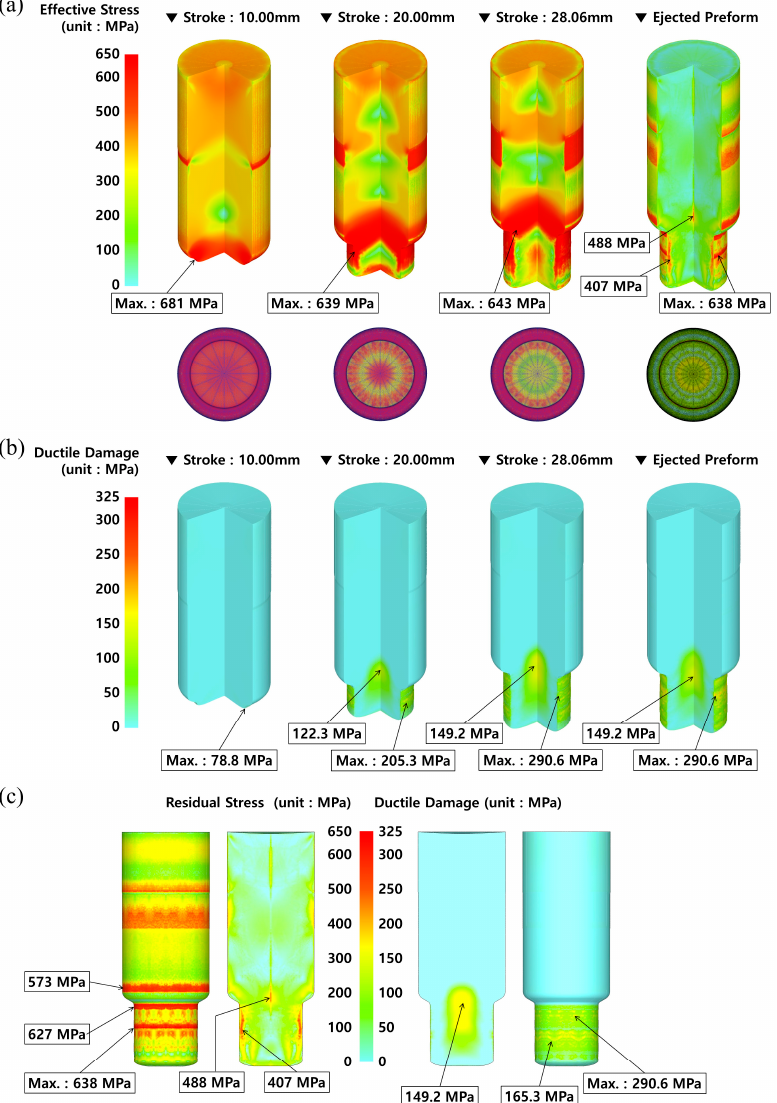
Figure 11. Numerical simulation results in the case where elasto-plastic material model was applied: ( a ) effective stress distribution; ( b ) plastic deformation damage distribution; ( c ) distribution of residual stress and plastic deformation damage after preform ejection.